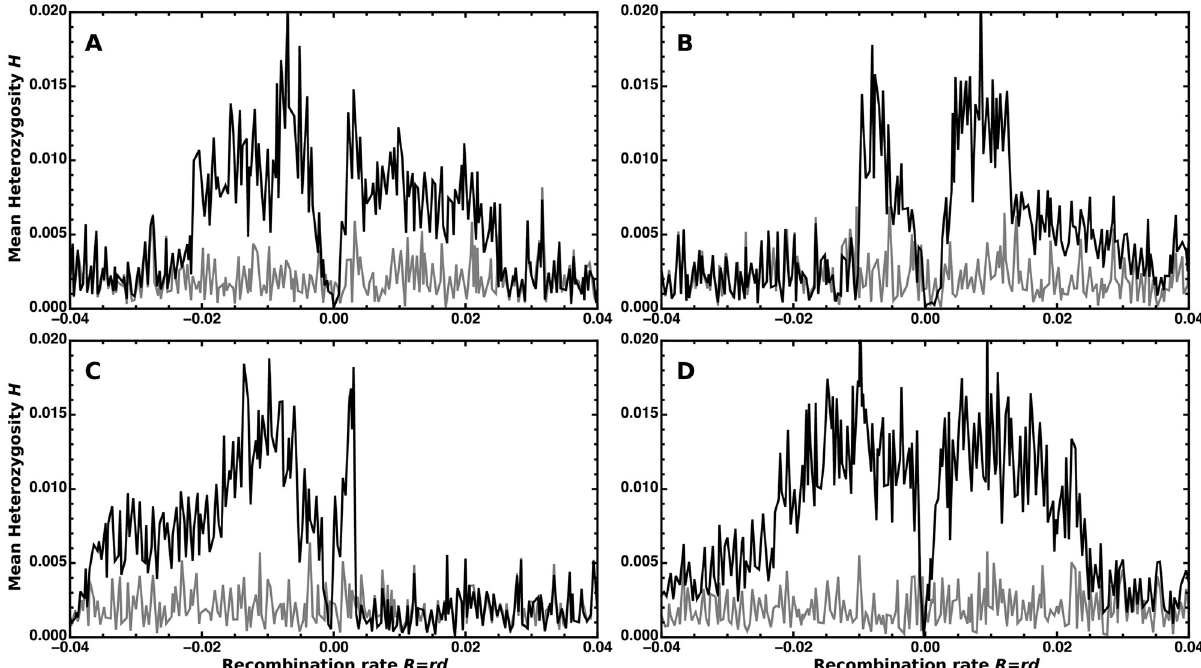
Fig 3. Single iterations of an adaptive introgression event. Each of the panels A, B, C, and D shows an independent, randomly chosen simulation run. We calculated the whole-population mean genetic diversity in 401 non-overlapping non-adjacent one kb windows separated by one kb and centred on the selected locus. The initial heterozygosity and the genetic diversity at fixation of the beneficial B allele are shown in grey and black, respectively. Here, θ = 0.002 ( N = 5 000, μ = 10 − 7 ), r = 10 − 7 , T d = 6 ( D = 13 θ ), and s = 0.06 (2 Ns = 600).